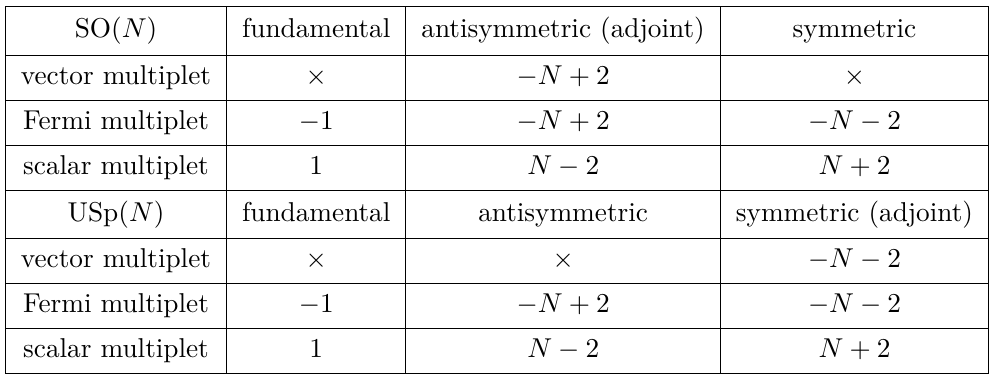
Table 6 . Anomaly contributions of the 2 d N = (0 , 1) multiplets in various representations of SO( N ) and USp( N ) .